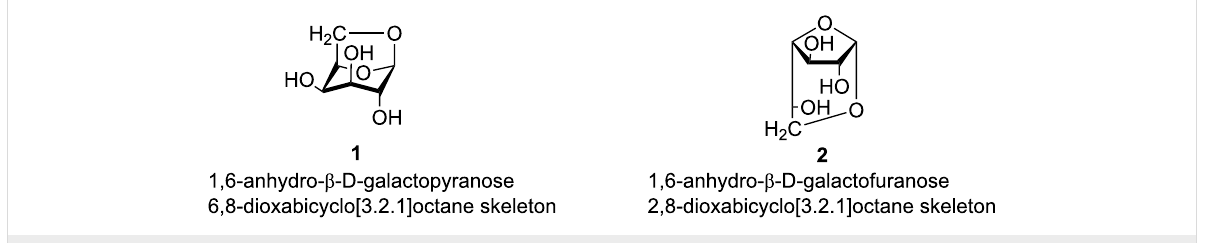
Figure 1: Possible 1,6-anydro derivatives for D-galactose.